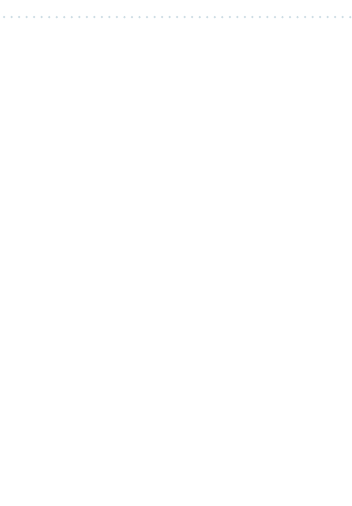
Figure 4. ( a ) Displacement response of the skin tissue in the z-direction to a single-pulse heat source with different step times, ( b ) comparison of the displacement response of the skin tissue in the depth direction with its response in the radial direction.